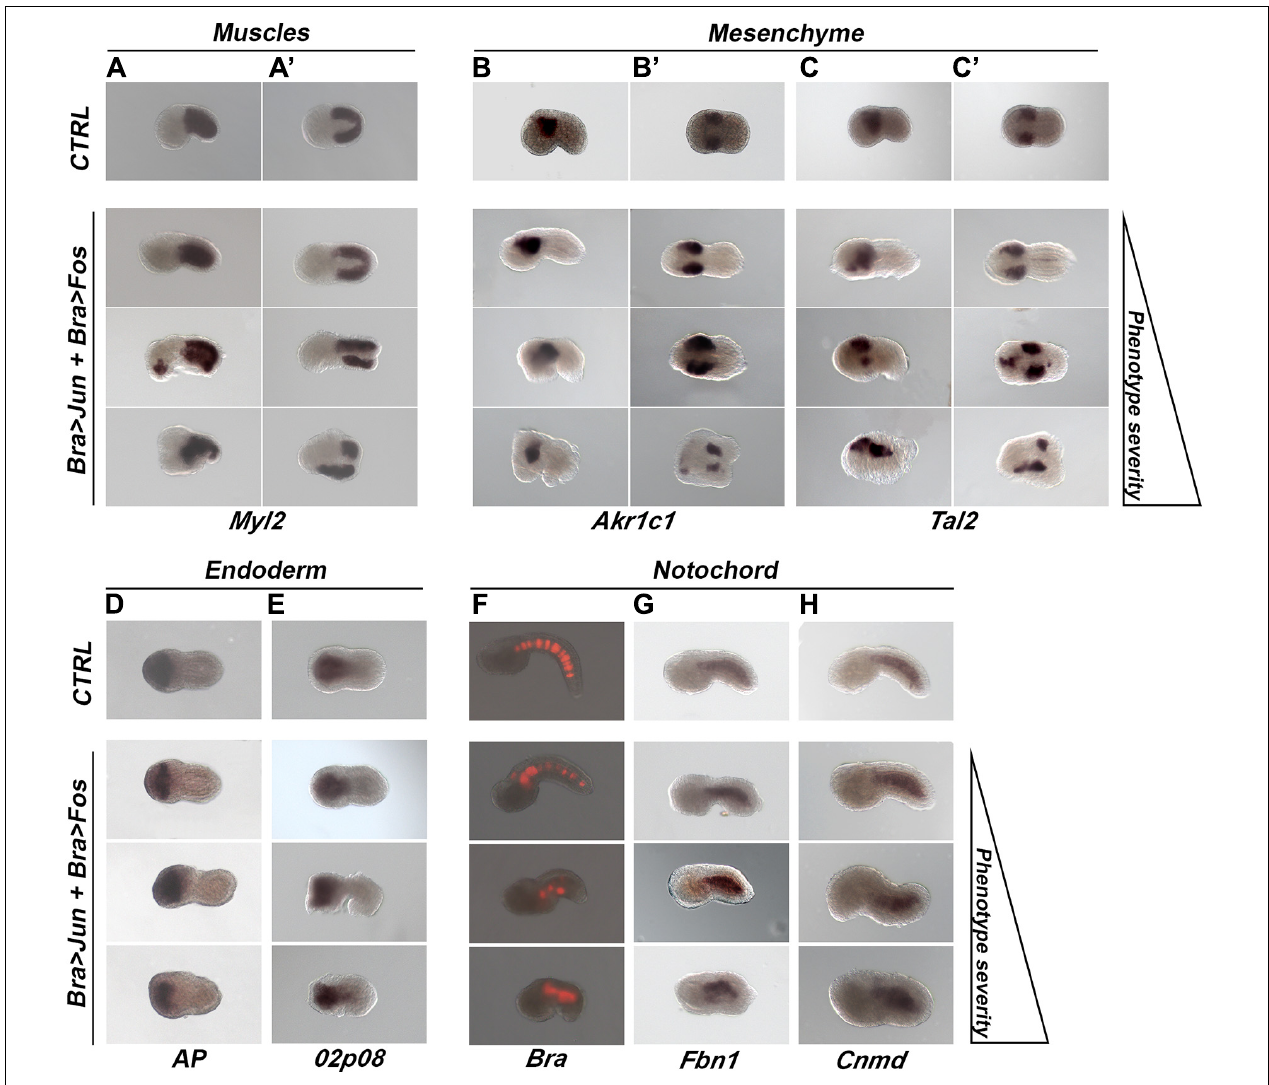
FIGURE 4 | Tissue differentiation in transgenic embryos (stage 17/18) co-electroporated with 10 µ g of Bra > Jun and Bra > Fos constructs. (A,A’) Muscle differentiation; whole-mount in situ hybridization (WISH) experiments with the muscle marker gene Myosin Light Chain 2 ( Myl2 ). (B–C’) Mesenchyme differentiation; WISH experiments with mesenchyme markers (B,B’) Aldo-Keto Reductase Family 1 Member C1 ( Akr1c1 ); (C,C’) TAL BHLH Transcription Factor 2 ( Tal2 ). (D,E) Endoderm differentiation. (D) Alkaline phosphatase (AP) assay to detect the endogenous AP enzymatic activity. (E) WISH experiment with the endoderm-specific gene KH2012:KH.L141.45. (F–H) Notochord differentiation. (F) Fluorescent images showing reporter gene [red fluorescent protein (RFP)] expression under the control of the Brachyury ( Bra ) promoter in embryos tri-electroporated with 10 µ g of Bra > Jun , Bra > Fos , and Bra > RFP. (G,H) WISH experiments with the notochord markers (G) Fibrillin 1 ( Fbn1 ) and (H) Chondromodulin ( Cnmd ). CTRL, Bra > RFP control embryos; Bra > Jun + Bra > Fos, co-electroporated embryos. In each column, embryos have been placed according to the progressive severity of the phenotype: normal (top), mild (middle), and severe (bottom) alterations. For all embryos, the anterior is on the left. (A–C,F–H) Lateral view; (A’,B’C’,D,E) , dorsal